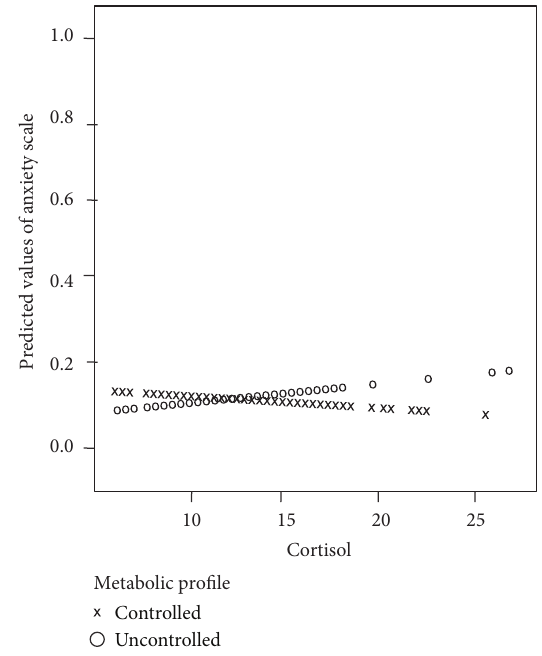
Figure 2: Predicted values of anxiety scale by cortisol and metabolic profile.